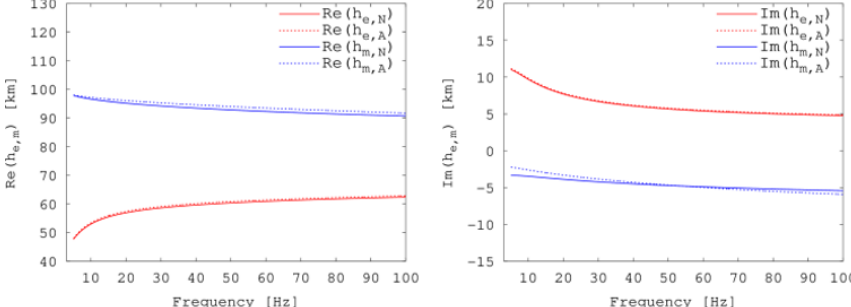
Figure 4. Real and imaginary parts of characteristic electric and magnetic altitudes obtained analytically (denoted by “A”) and from the FDTD model (denoted by